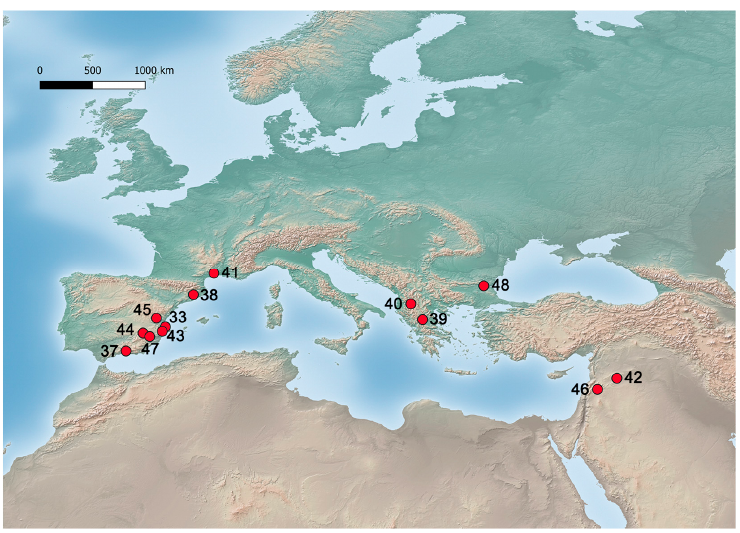
Figure 5. Early Upper Pleistocene (MIS 5, 4 and 3) sites where Celtis remains were reported (numbers in the figure correspond to ID numbers in Table 3) (map generated using QGIS version 3.4.13; Source: Natural Earth Data).